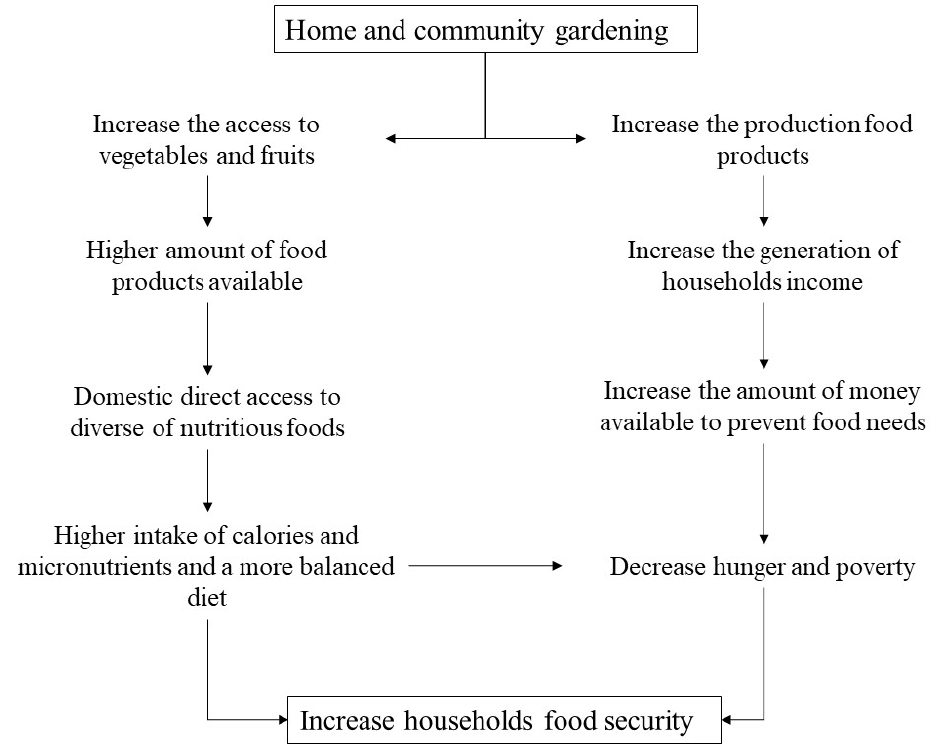
Figure 2. Pathways of contribution of home (and community) gardening to food security.